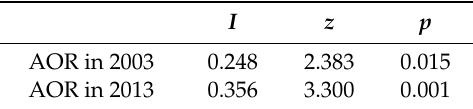
Figure 3. Quantile maps: ( a ) spatial distribution of AOR of natural wetlands in 2003; ( b ) spatial distribution of AOR of natural wetlands in 2013. Note: there are 34 provinces in China, including 1=Beijing, 2=Tianjin, 3=Hebei, 4=Liaoning, 5=Jilin, 6=Heilongjiang, 7=Inner Mongolia, 8=Gansu, 9=Qinghai, 10=Xinjiang, 11=Tibet, 12=Yunnan, 13=Sichuan, 14=Ningxia, 15=Shaanxi, 16=Chongqing, 17=Guizhou, 18=Guangxi, 19=Hunan, 20=Hubei, 21=Henan, 22=Shanxi, 23=Shandong, 24=Anhui, 25=Jiangxi, 26=Guangdong, 27=Fujian, 28=Zhejiang, 29=Jiangsu, 30=Shanghai, 31=Taiwan, 32=Hong Kong, 33=Macau, 34=Hainan. Table 2. Moran’s I test for global associations.